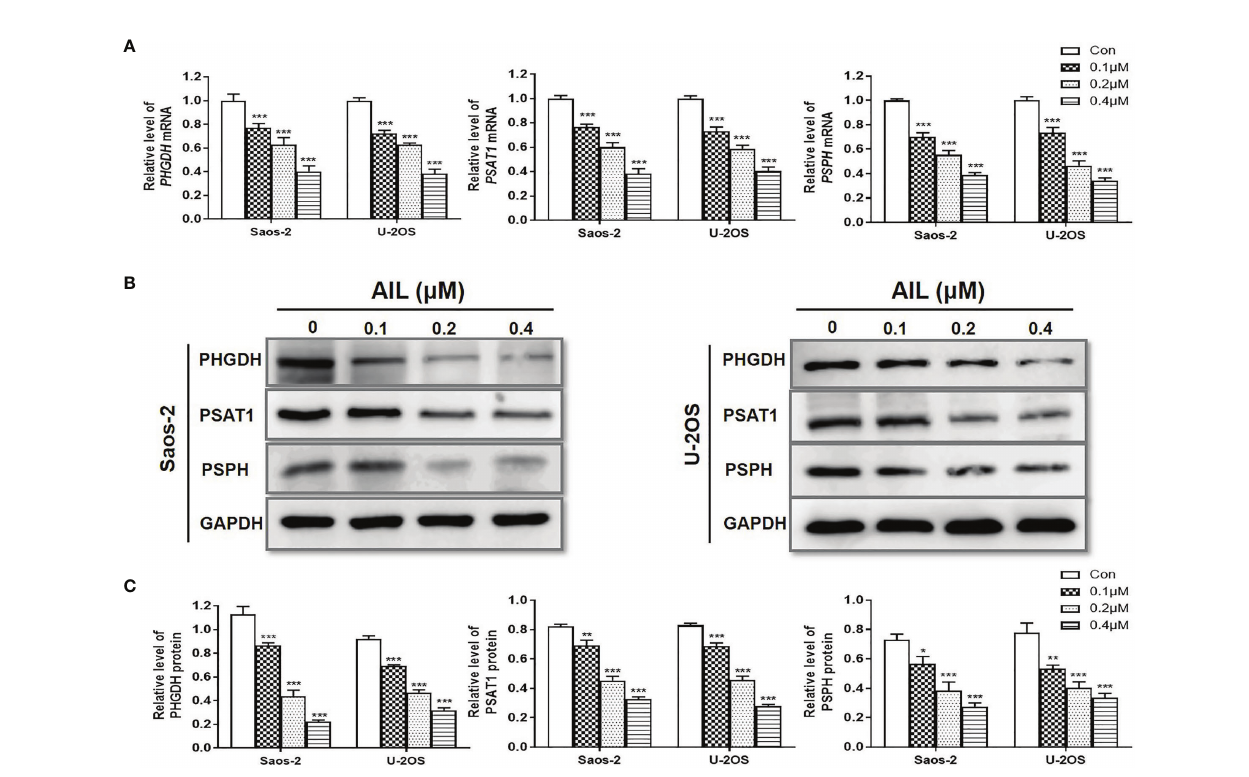
FIGURE 6 | Treatment with AIL led to reduced SSP expression. (A) qRT-PCR revealed that the PHGDH , PSAT1 and PSPH mRNA levels were downregulated by AIL dose-dependently in Saos-2 and U-2OS cells (* P < 0.05, ** P < 0.01, *** P < 0.001 compared with the control). (B) The expression of PHGDH, PSAT1 and PSPH protein was downregulated by AIL dose-dependently in Saos-2 and U-2OS cells. (C) Data of relative protein level were pooled from three independent experiments (* P < 0.05, ** P < 0.01, *** P < 0.001 compared with the